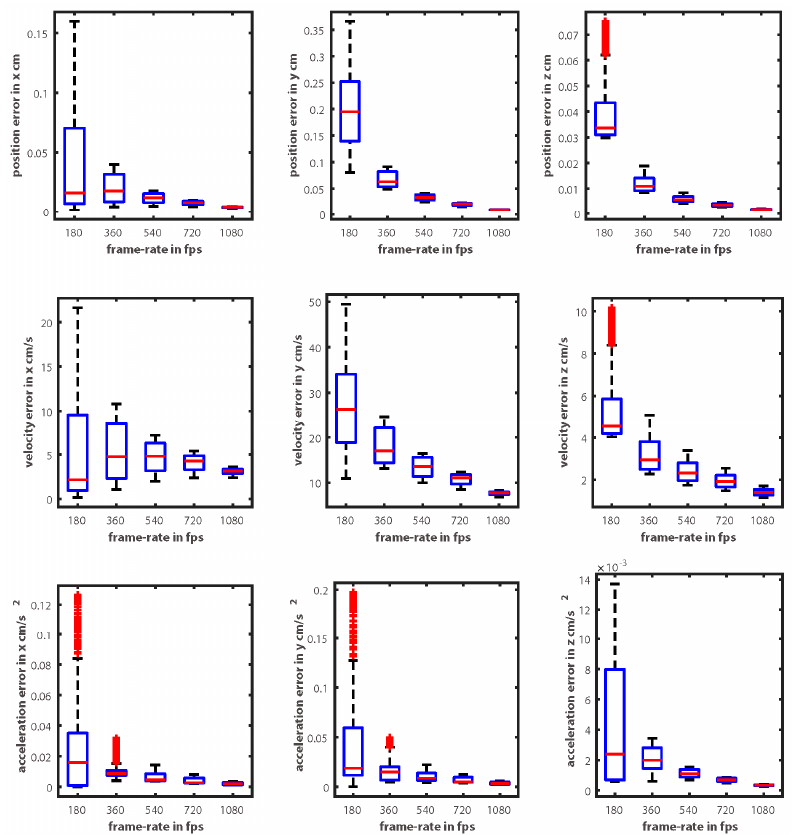
Figure 4. Boxplot of position error, velocity error and acceleration error (cm/s 2 ) in three axes of the world coordinate with a frame ‐ rate from 180 to 1080 FPS.